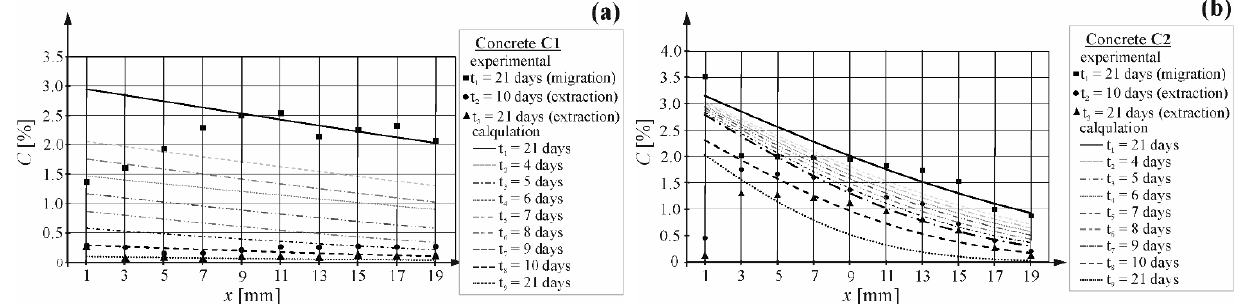
Figure 9. Distribution of chloride concentration in concrete obtained in the extraction process—calculated and obtained from tests: ( a ) concrete C1; ( b ) concrete